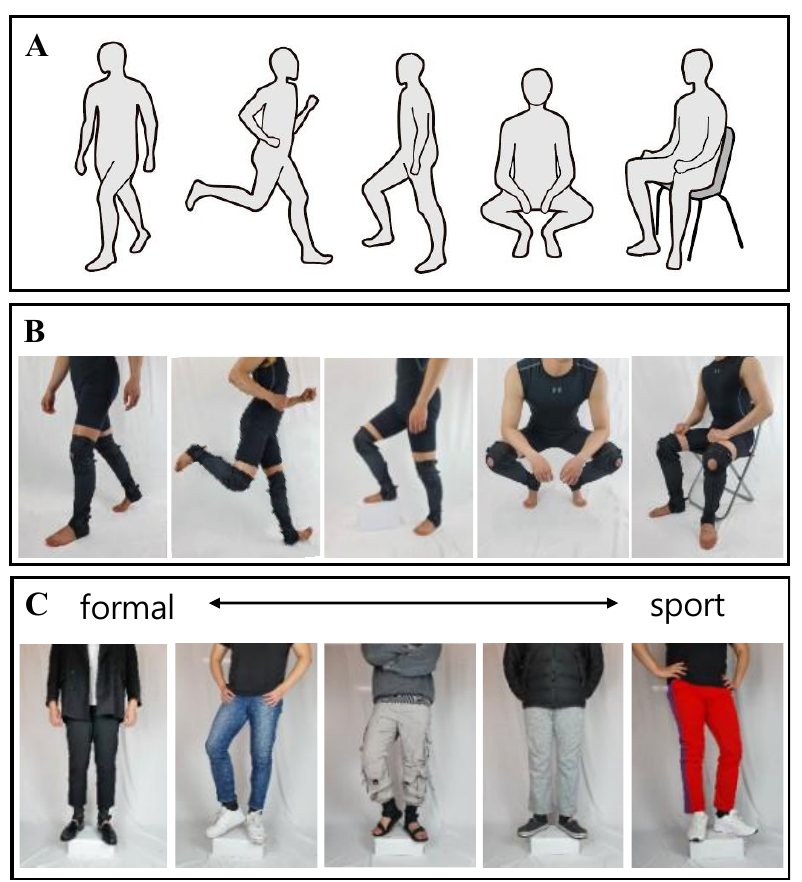
Figure 8. ( A ) Humans perform various movements in daily life. The lighter and simpler design of kneE-XOcks can serve as an immense advantage in everyday life. ( B ) Various movement performance tests and ( C ) various types of clothing tests demonstrate that wearing kneE-XOcks does not interfere with daily movement performance and is not restricted by any type of clothing.